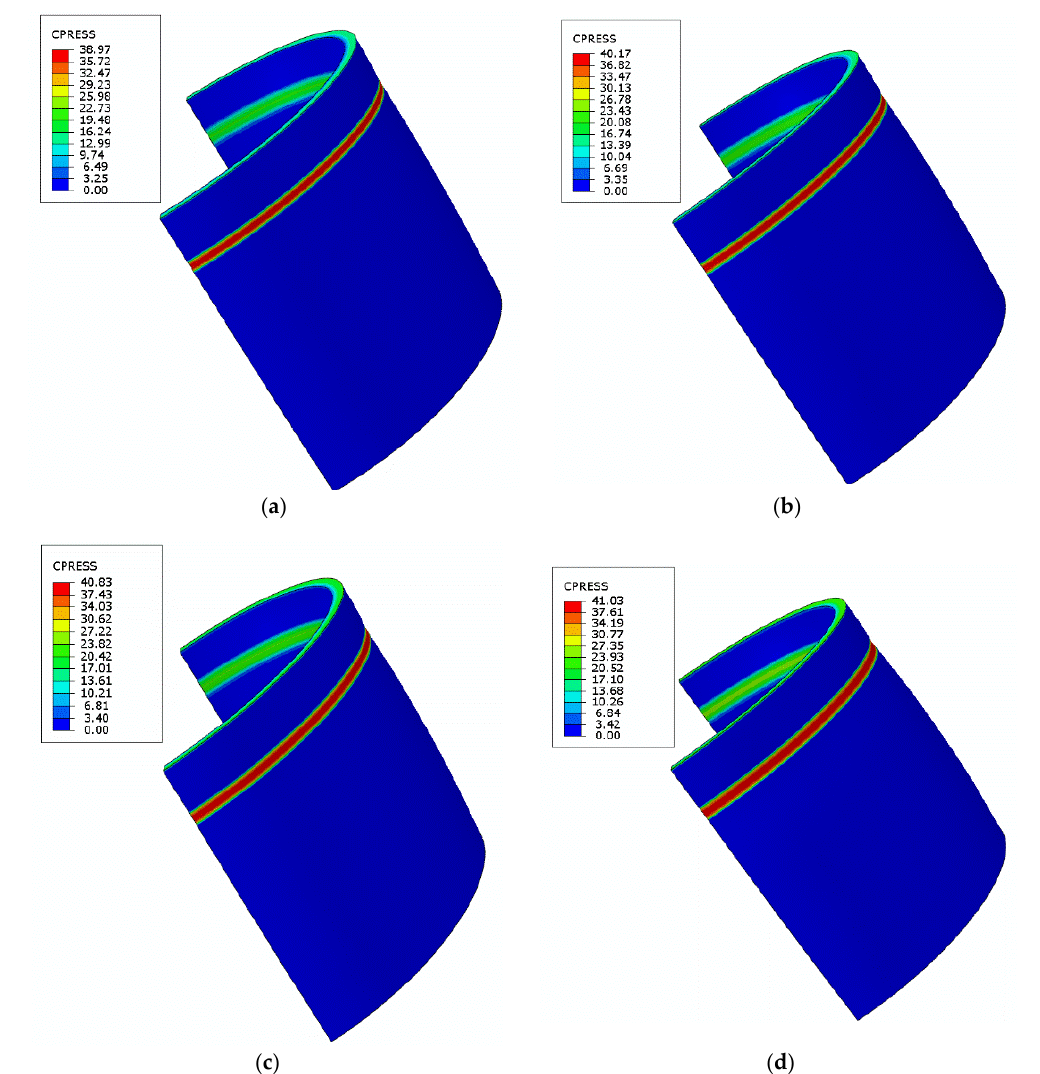
Figure 11. Contact pressure distribution of the polymeric sheath: ( a ) 50 °C; ( b ) 60 °C; ( c ) 70 °C; ( d ) 80 °C.